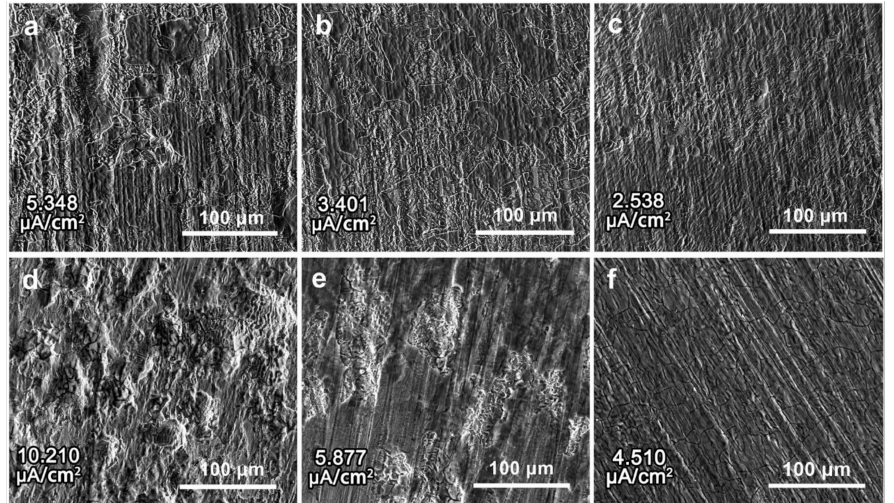
Figure 10. Representative SEM surface morphologies of some 90/10 copper–nickel alloy wires in the WBE after 168 h impingement at 5 m/s using 1 wt.% NaCl solution without sand particles: ( a ) wire 0403, ( b ) wire 0705, ( c ) wire 0707; and with 0.2 wt.% sand particles: ( d ) wire 0402, ( e ) wire 0504, ( f ) wire